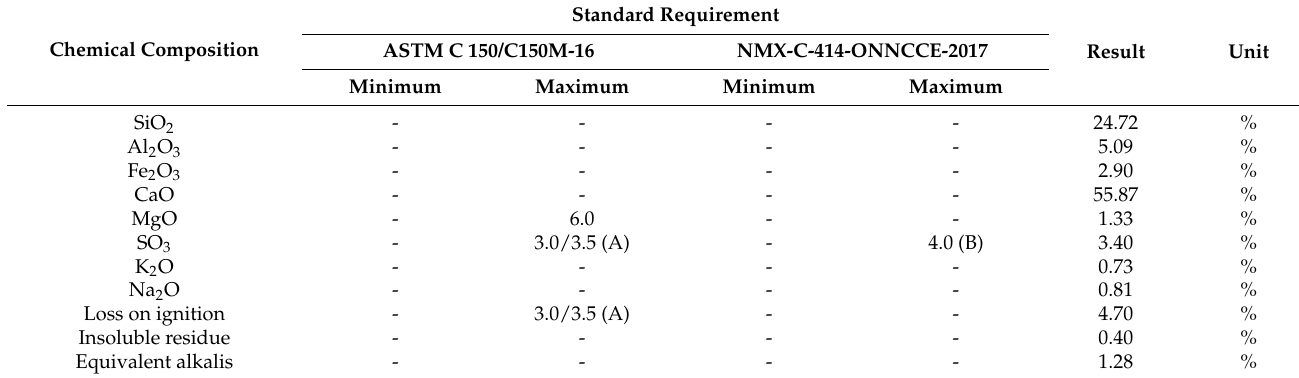
Table 1. Chemical composition of cement.